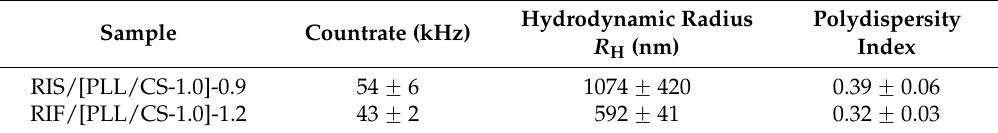
Table 3. DLS parameters countrate and hydrodynamic radius of drug loaded PLL/CS particles. Hydrodynamic Radius Polydispersity Sample Countrate (kHz) R H (nm) Index RIS/[PLL/CS-1.0]-0.9